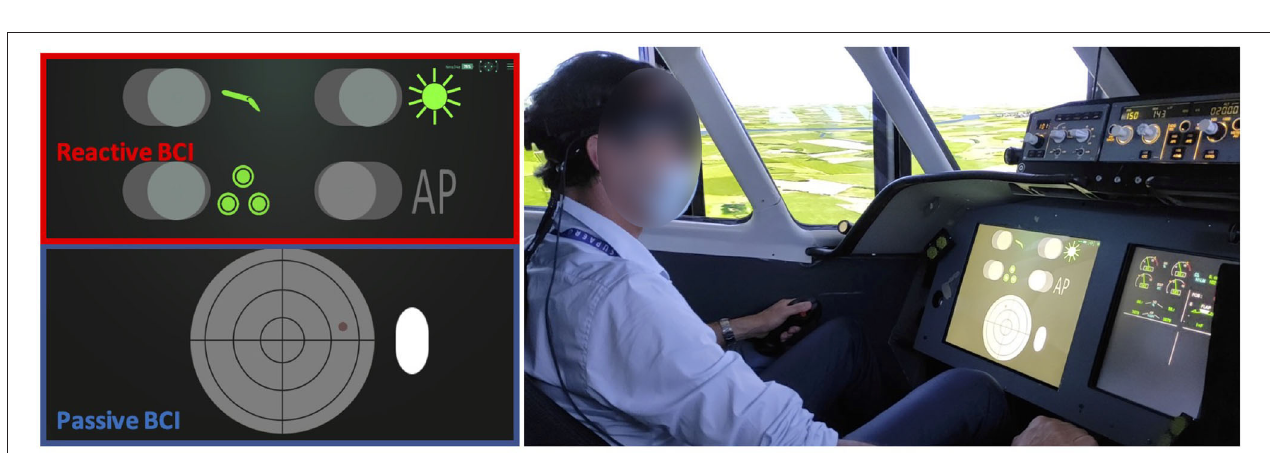
FIGURE 1 | Implementation of our dual passive and reactive Brain Computer Interface in the cockpit. It enables human-machine bi-directional communication: (1) the pilots can directly interact with some flight deck actuators (e.g.., the landing gears—as shown by the red rectangles) using information from the EEG signal, and (2) the flight deck can send visual feedback to the pilot and adapt the interaction when poor cognitive performance is detected.